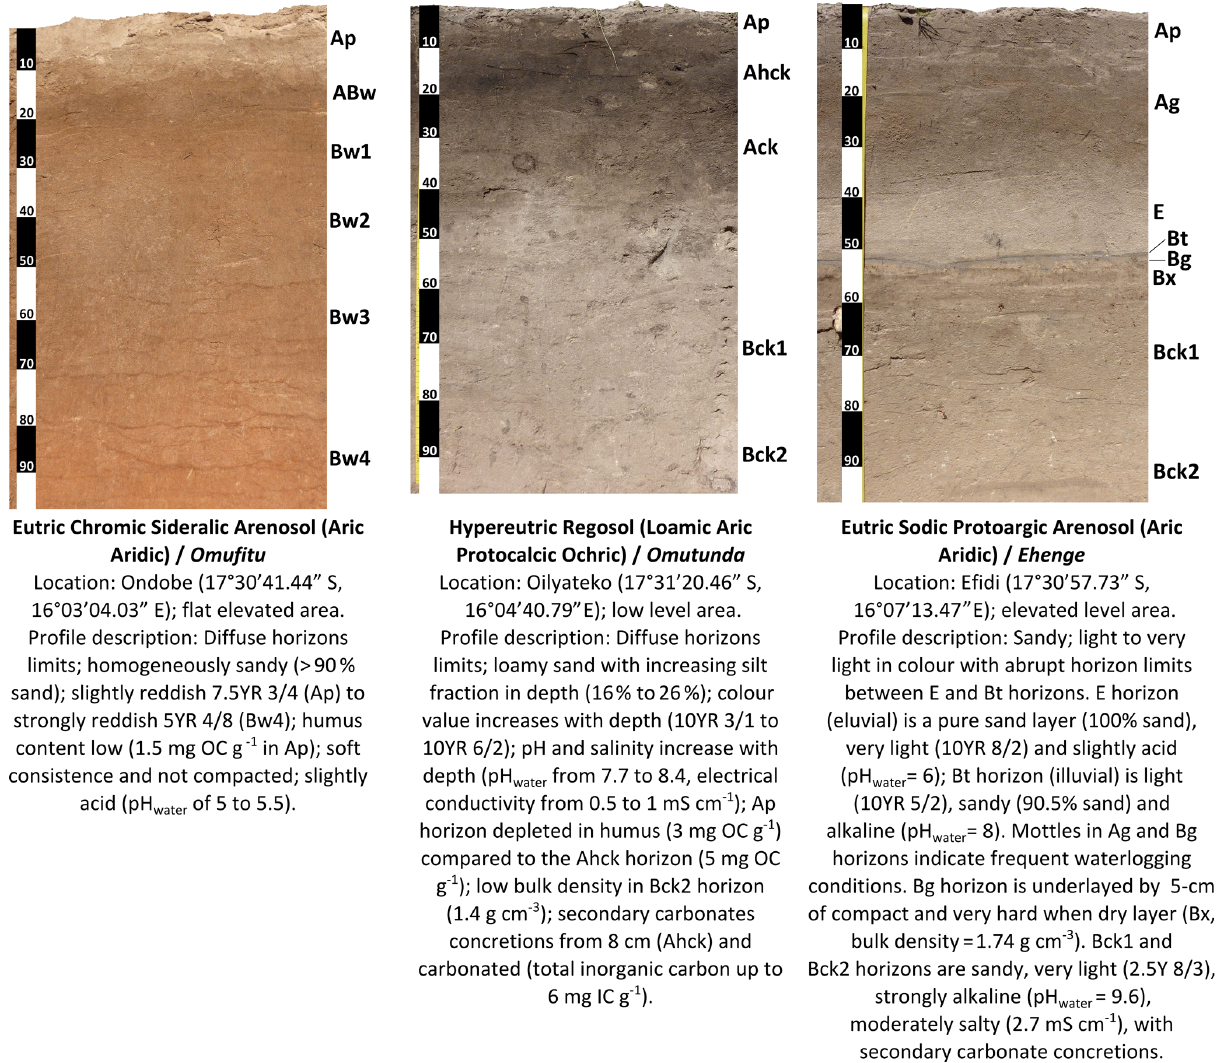
Figure A1. Soil profiles illustrating three of the most common KwSUs found in the area. Soil descriptions follow the Guidelines for soil description (FAO, Land and Water Division, 2006) and soil names of the World Reference Base for Soil Resources (IUSS Working Group WRB,